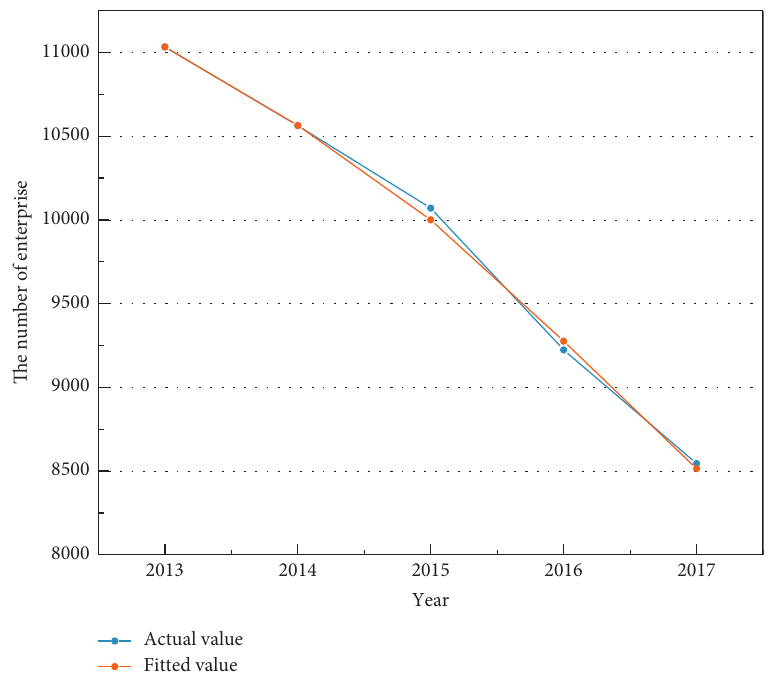
Figure 2: Comparison of actual value and fitting value. Table 1: Comparison of fitting values of different models.